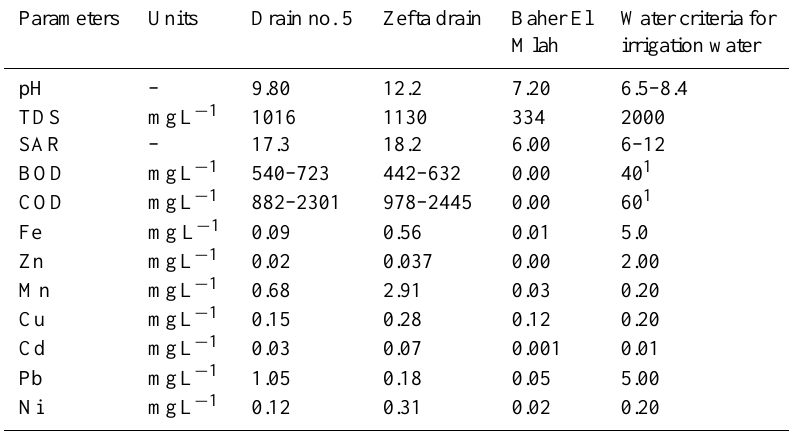
Table 3. The chemical analysis of water collected from the Zefta drain, drain no. 5, and Baher El Mlah canal. Parameters Units